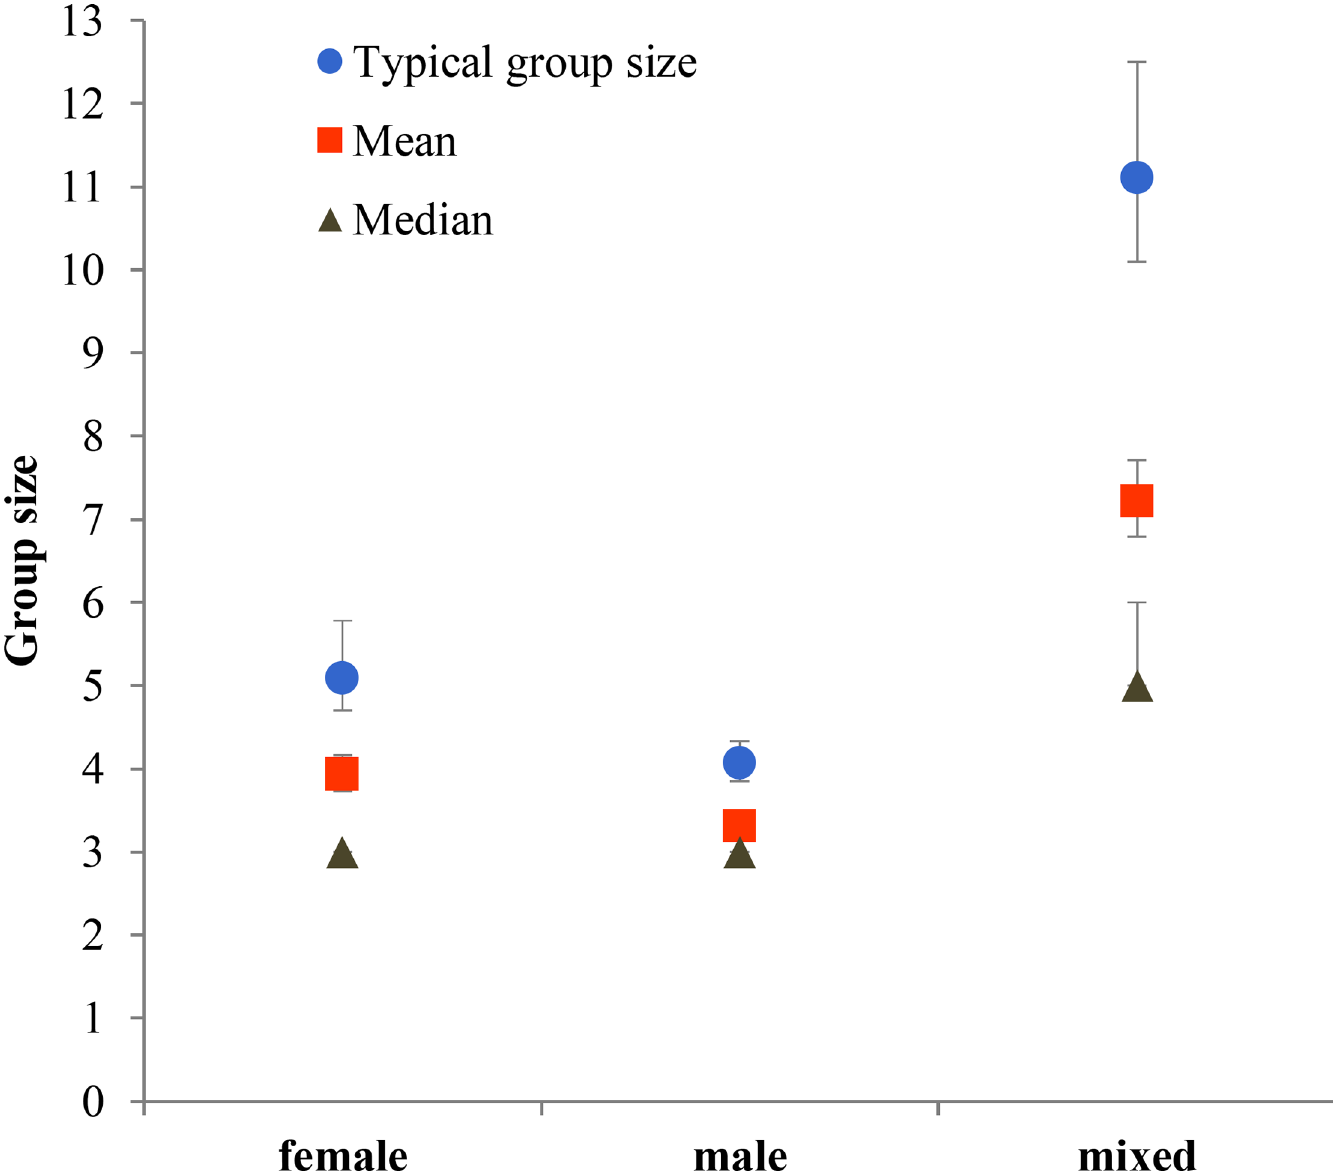
Fig 5. Typical, mean and median group sizes according to group type. In typical and mean group sizes bars are 95% confidence intervals (CIs); in median group size CIs range between 95% and 96.2%. See S1 Table for detail